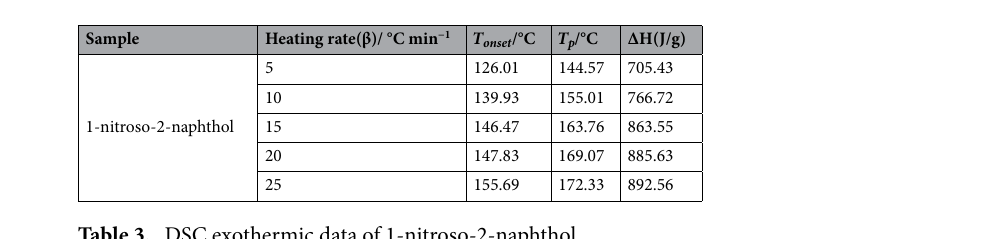
Table 3. DSC exothermic data of 1-nitroso-2-naphthol.